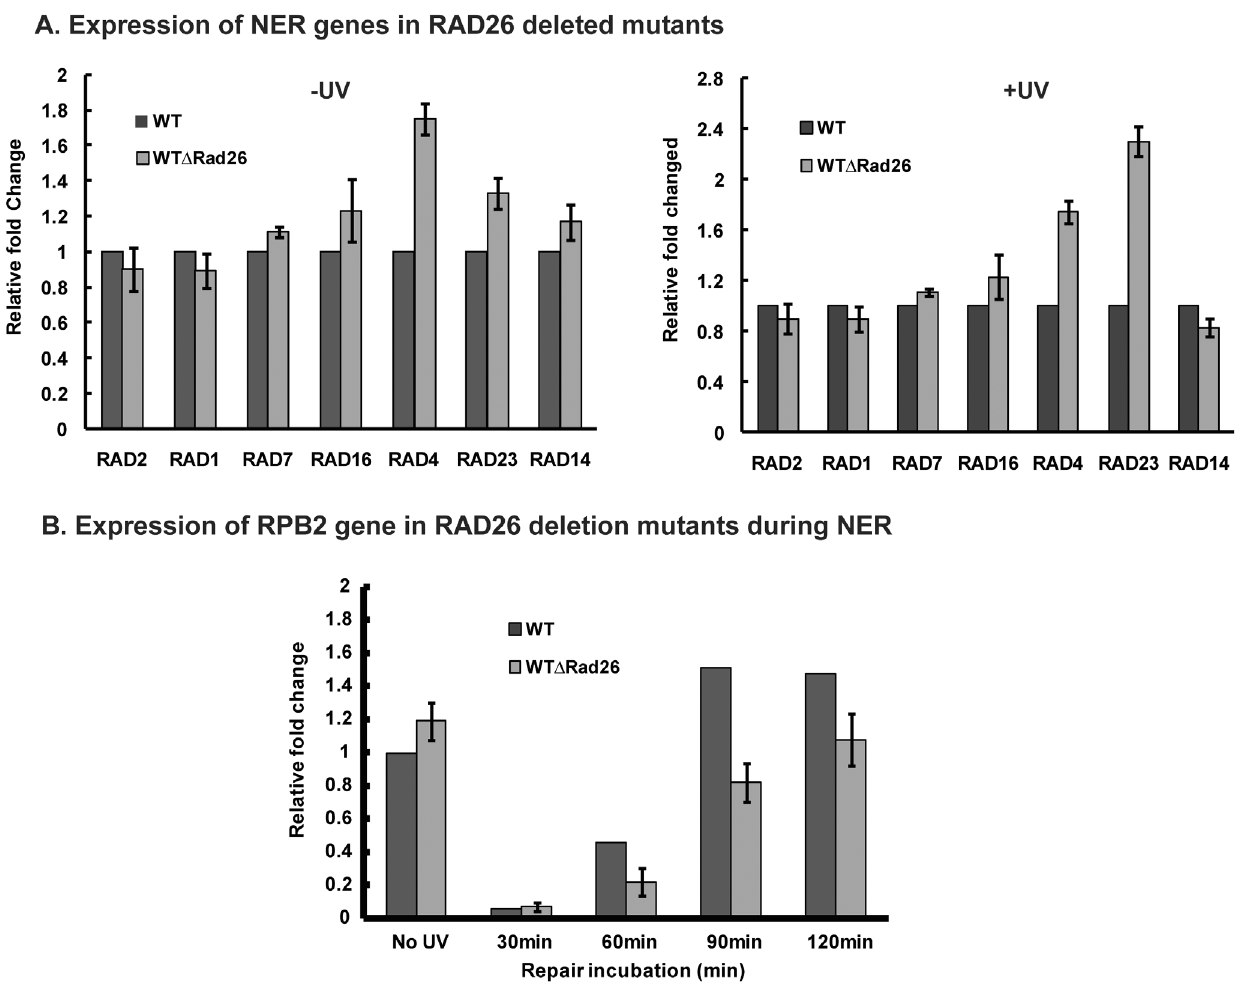
Figure 3. Expression analyses of NER genes and RPB2 gene. RT–PCR analysis was performed on total RNA isolated from WT and WT D Rad26 cells ( A ) following treatment without or with 100 J/m 2 UV radiation, using gene-specific primers, as described in Materials and Methods section; ( B ) of RPB2 gene after 100 J/m 2 UV irradiation followed by repair incubation for different time periods. For each strain, data represent the mean 6 1 SD for three independent experiments.